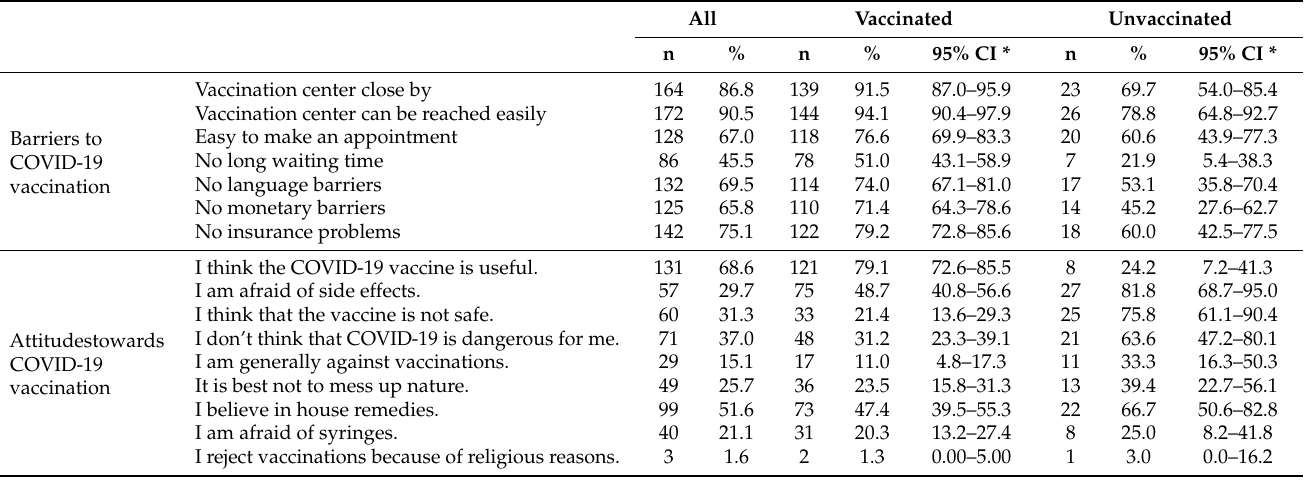
Table 2. Access barriers to vaccination and attitudes towards COVID-19 vaccination. All Vaccinated